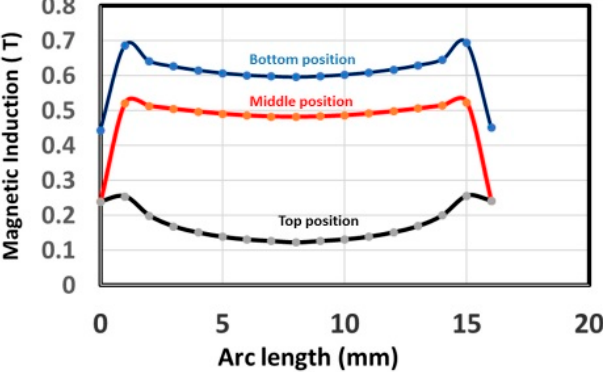
Figure 8. Magnetic induction as a function of arc length from bottom, middle, and top positions in the MRE sample.